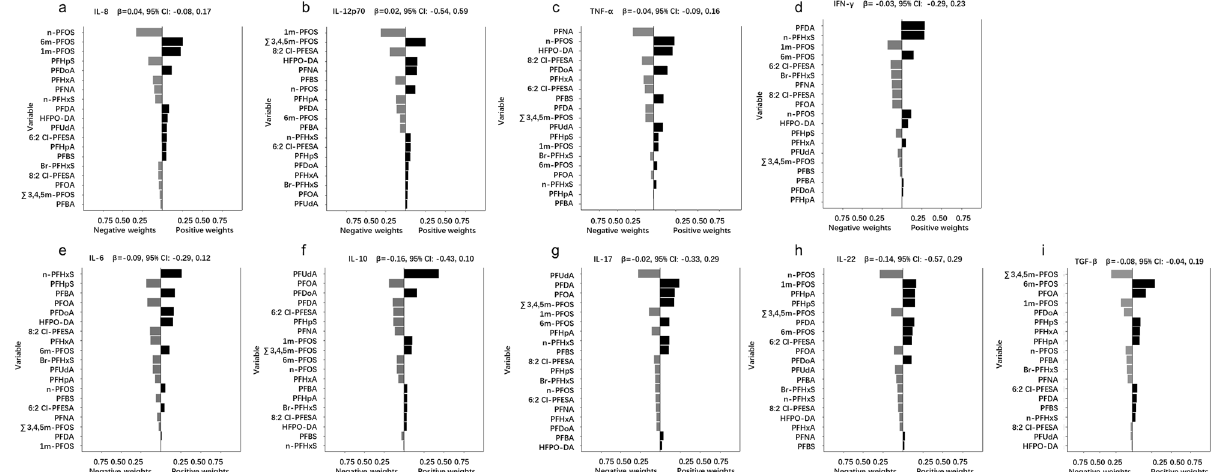
Figure 1. Quantile g-computation regression analysis of the relationship between PFAS levels and cytokines. Models were adjusted for age, BMI, age at menarche, and